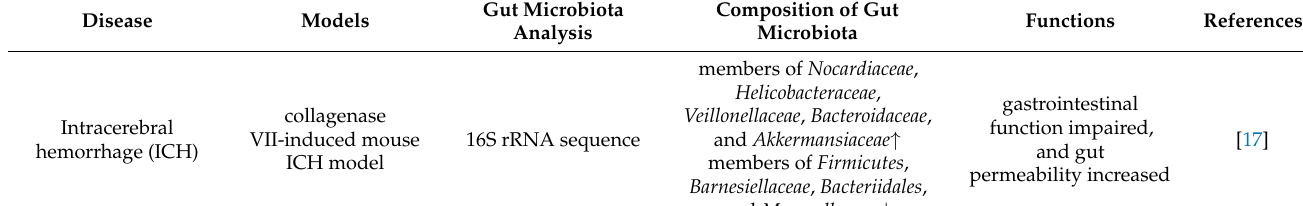
Table 2. Changes in the gut microbiota after intracerebral